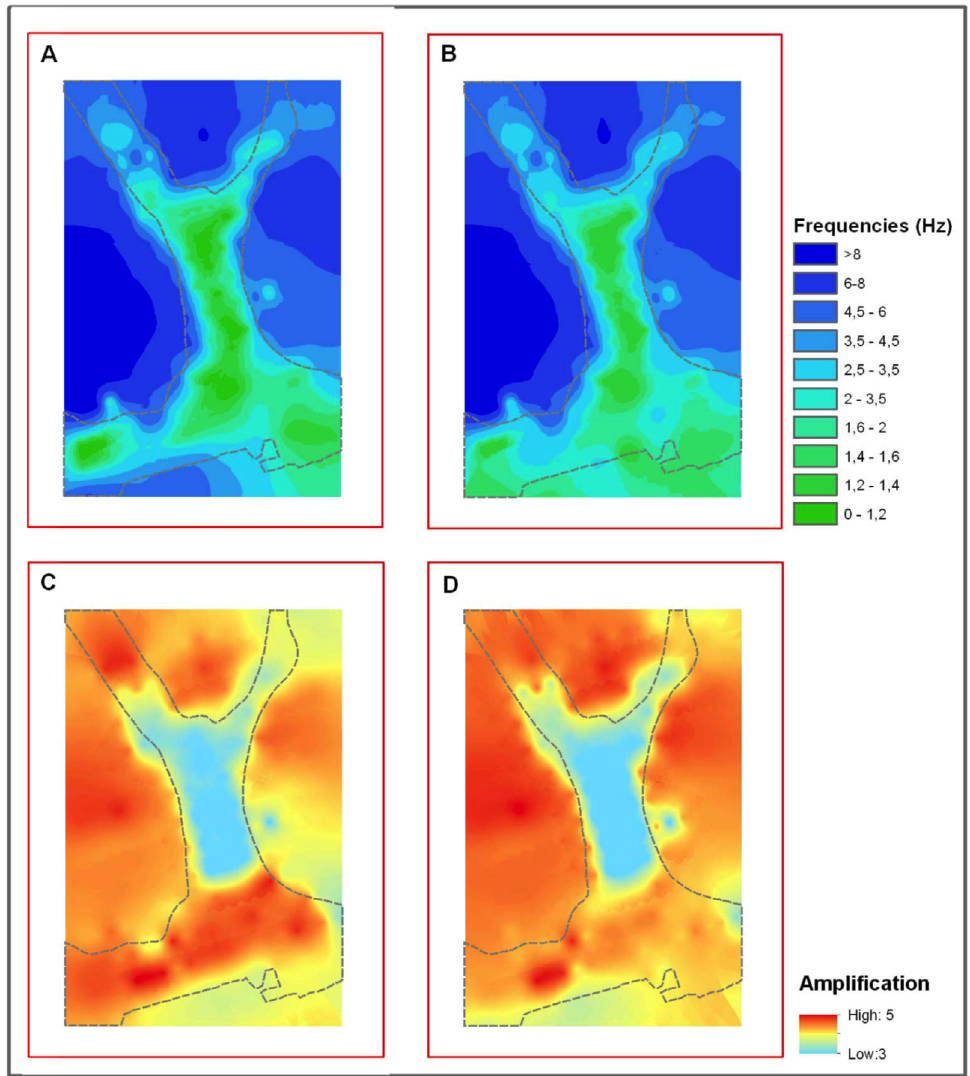
Figure 14. Fundamental frequencies (top) and the corresponding amplifications (bottom) for a near-field seismic motion (left) and a far-field seismic motion